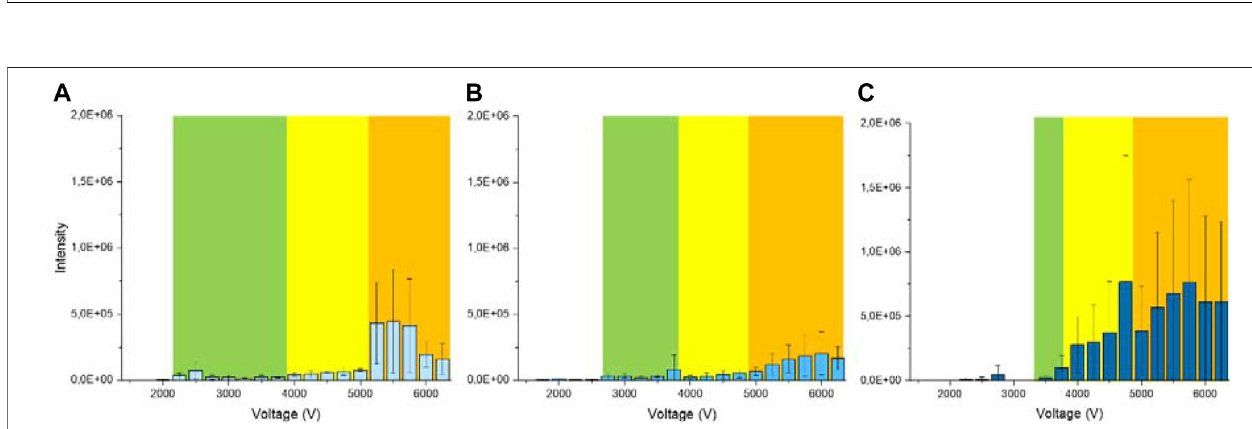
FIGURE1| Imagesofthesprayplumes obtainedfrom thesideofthepaperwithincreasingapplied voltagewithaspray fl owrateof50 μ L/min. (A) Novisiblespray jet, (B) single cone-jet mode, (C) multi-jet mode (two visible jets), (D) multi-jet mode (three visible jets), and (E) rim-jet mode.